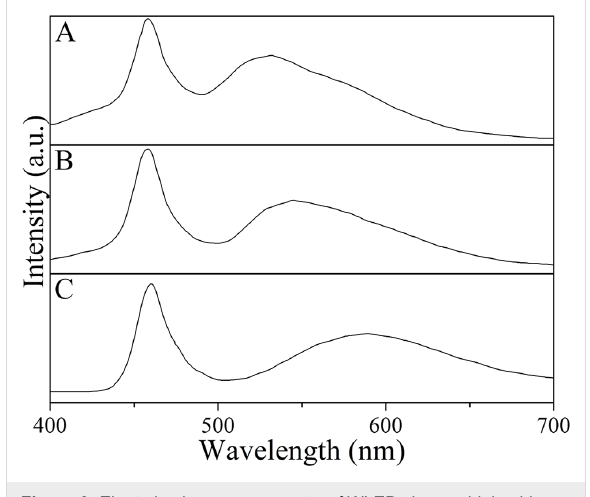
Figure 6: Electroluminescence spectra of WLEDs by combining blue LED chip with Y 2.96 Ce 0.04 Al 5 O 12 (A), Tb 2.96 Ce 0.04 Al 5 O 12 (B) and